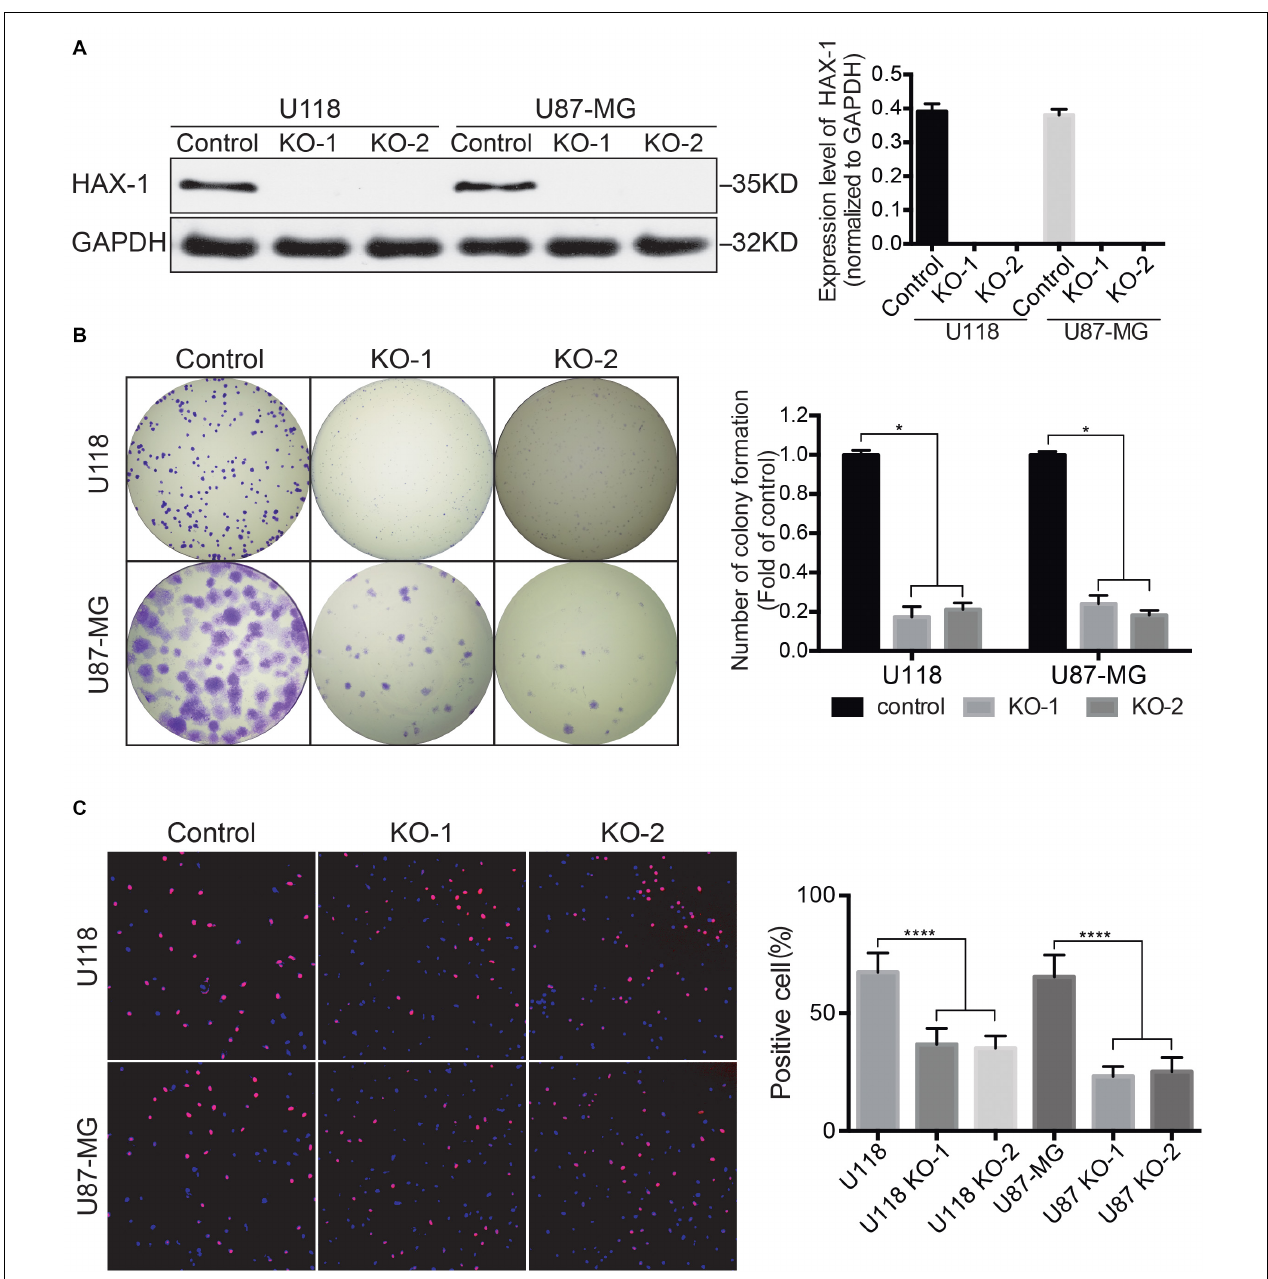
FIGURE 1 | HAX-1 regulated cell proliferation of glioblastoma cells. (A) Western blot showed that HAX-1 was completely knocked out in U118 and U87-MG. GAPDH was used as a loading control. (B) Colony formation assays indicated that the efficiency of colony formation of U118 and U87-MG cells declined after HAX-1 was knocked out. (C) Edu proliferation assays showed decreased proliferative U118 and U87-MG cells. Edu was labeled with red fluorescence and nuclei were stained with blue fluorescence. (magnification: 100 × ) Three individual experiments were performed for each group. ∗ P < 0.05, ∗∗∗∗ P <